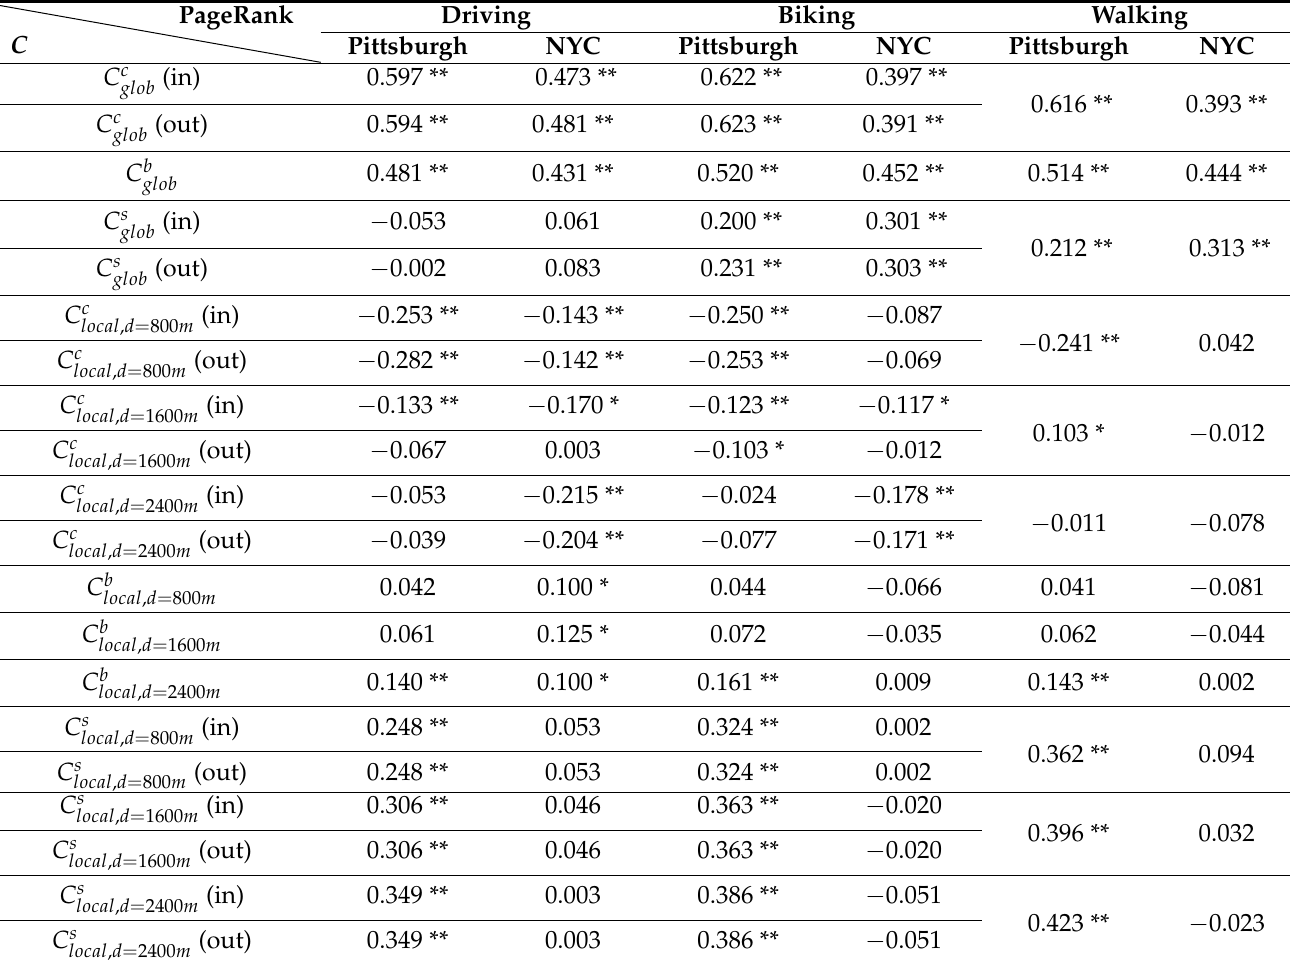
Table 4. Correlation results (* indicates a p -value < 0.05; ** indicates p -value < 0.01) by considering the road network as a directed network based on the accessibility of driving , biking and walking in either